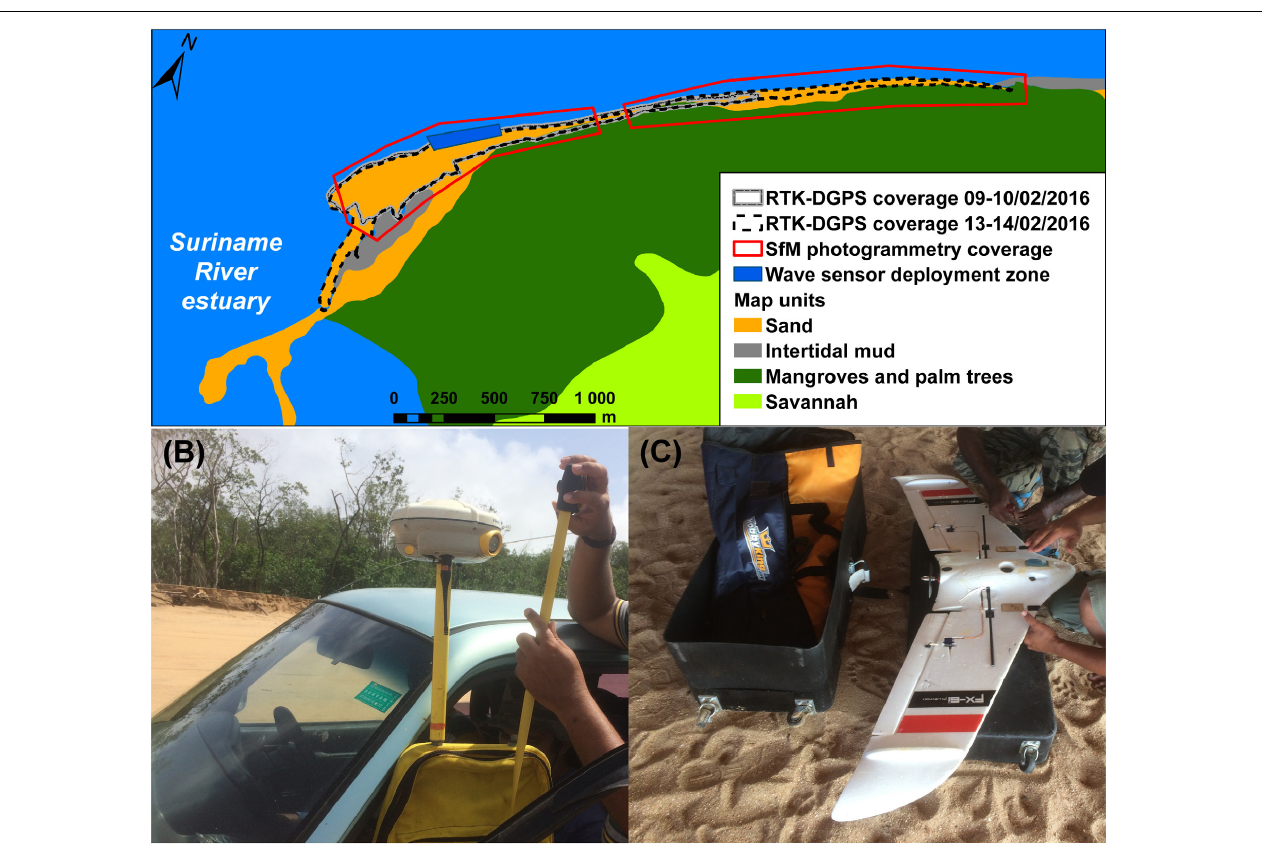
FIGURE 3 | (A) Experiments conducted on Braamspunt beach in February, 2016 and their ground coverage; (B) mobile GPS station on an all-terrain vehicle; (C) drone with custom-built wings used for photogrammetric survey.